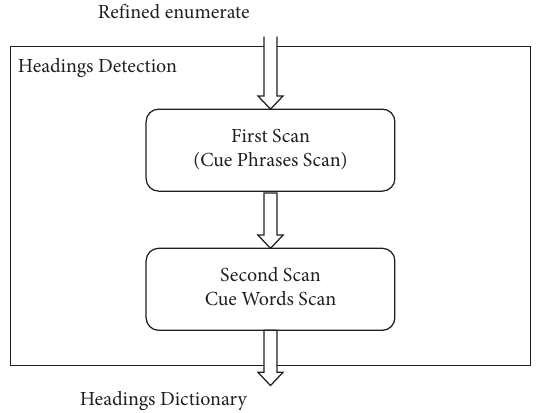
Figure 3: Headings detection